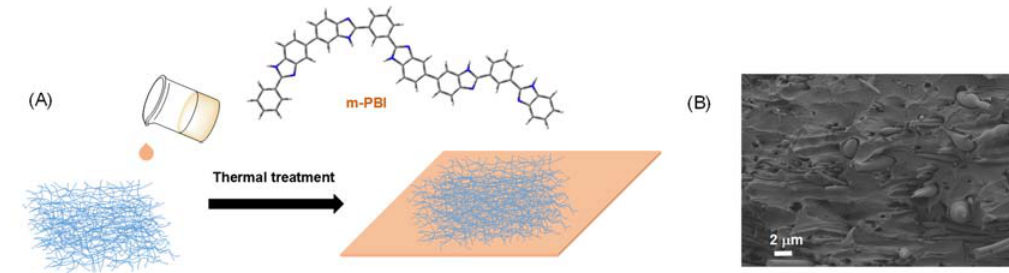
Figure 4. ( A ) Schematic representation of preparation of composite membrane containing SiNF, and ( B ) SEM image of composite membrane containing SiNF.